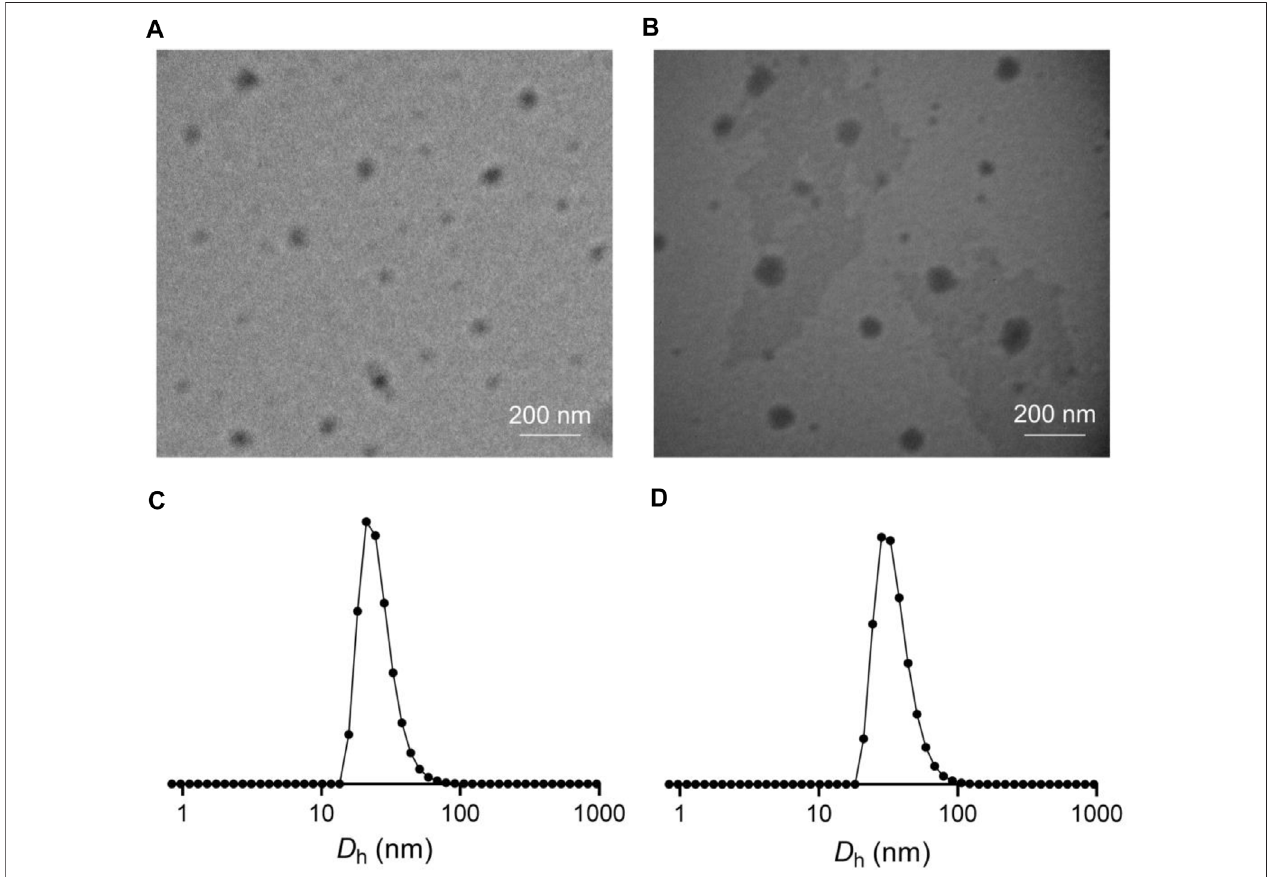
FIGURE 3 | Typical TEM images and D h s of NG (A,C) and NG/LEN (B,D) . D h s detected by DLS were preceded by intensity mode.